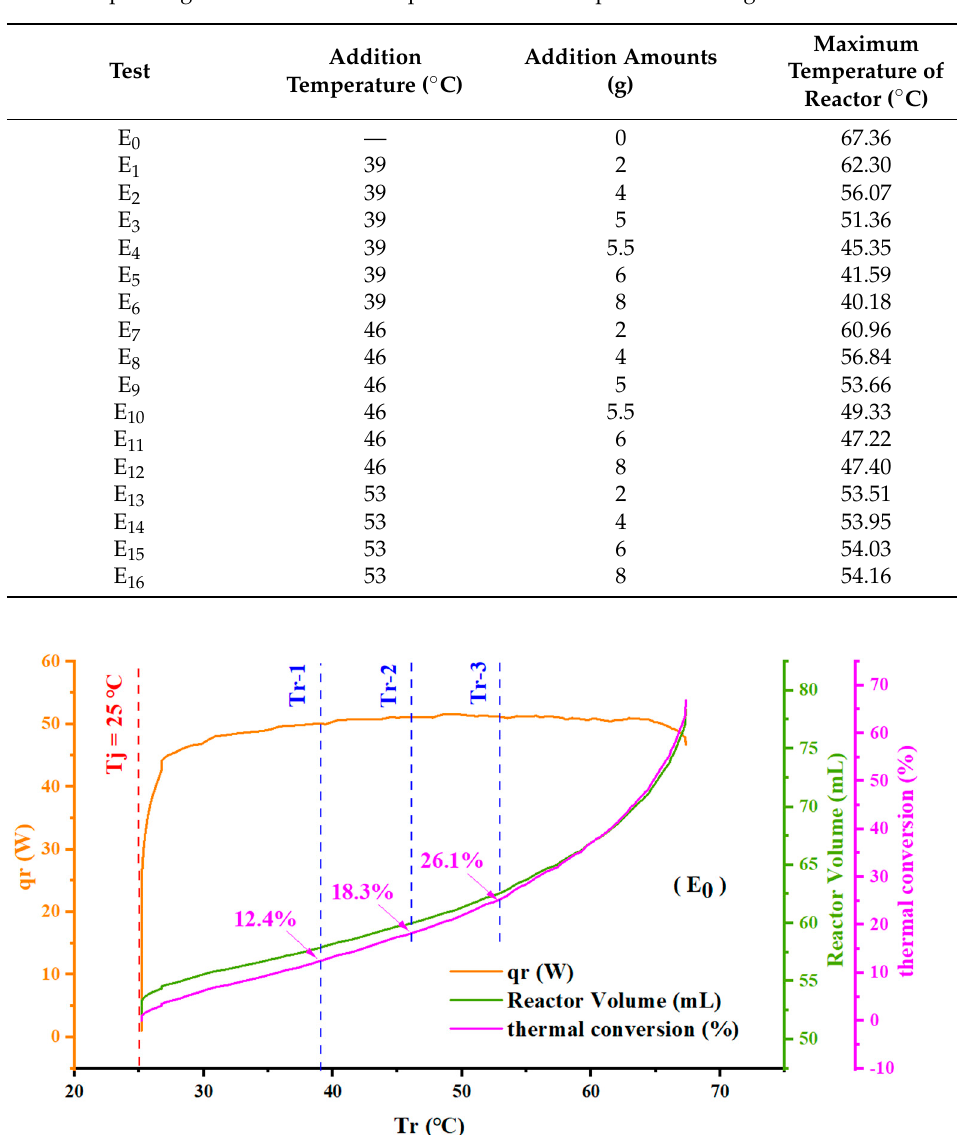
Table 5. Operating conditions of the temperature control experiments using the microPCMs.